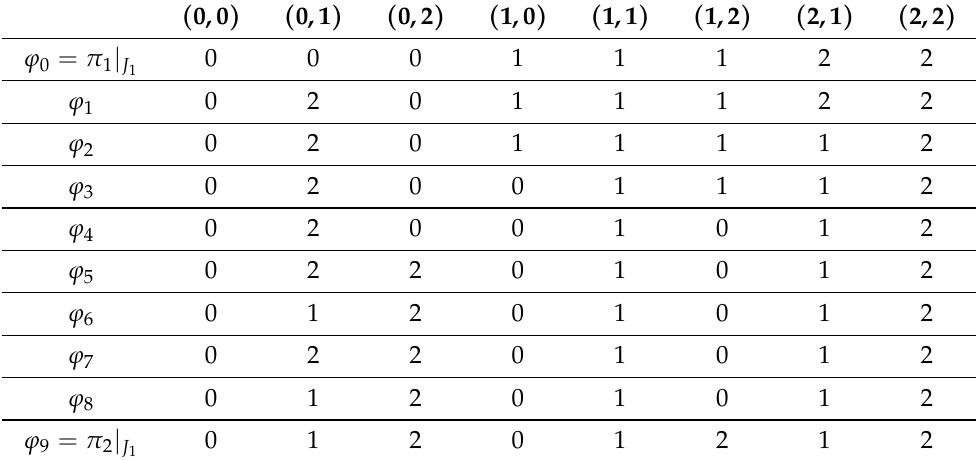
Table 2. Contiguity chain between π 1